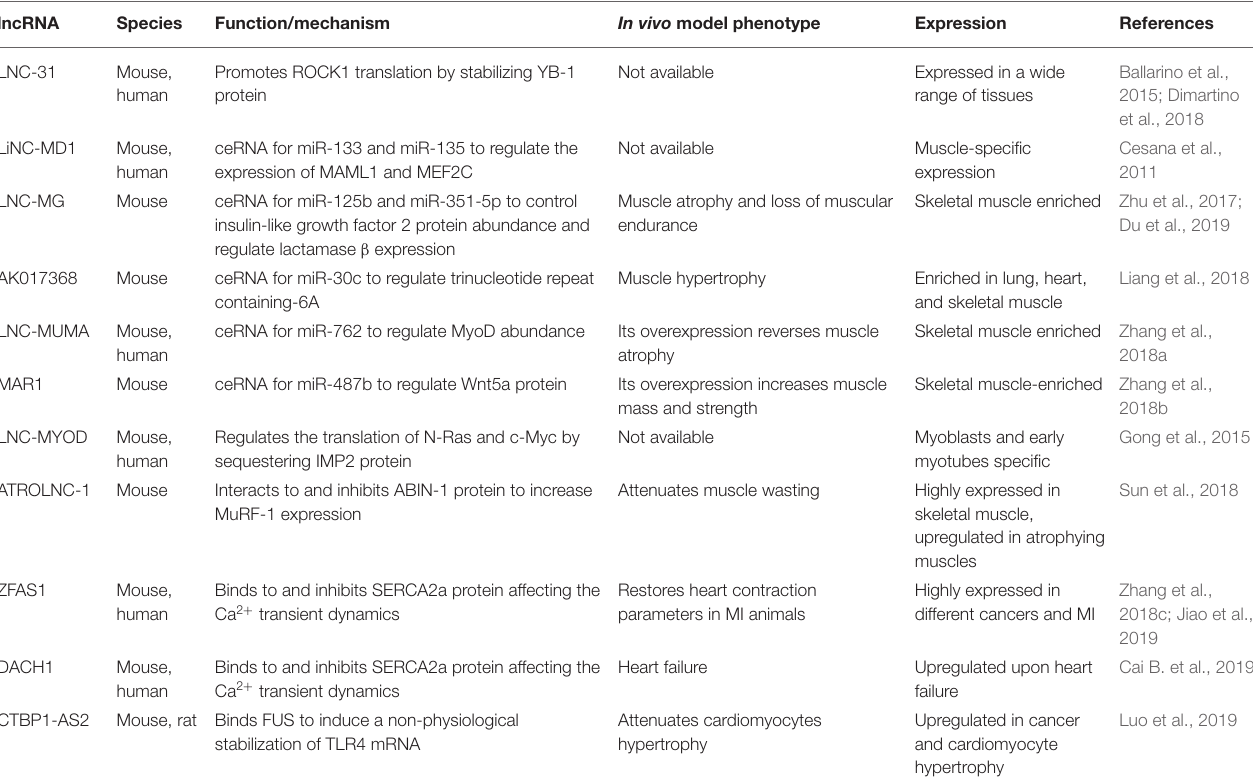
TABLE 2 | Cytoplasmatic long non-coding RNAs (lncRNAs) in skeletal and cardiac